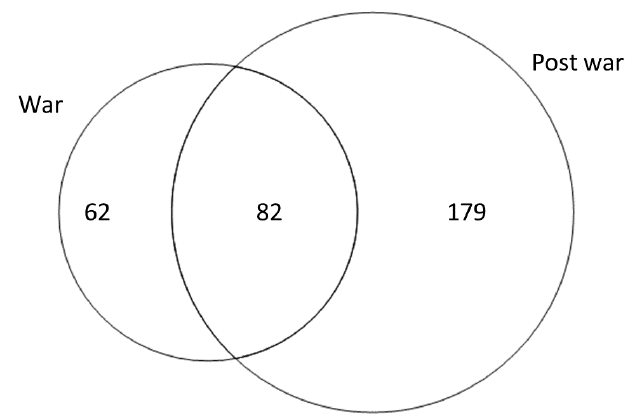
Figure 6. Venn diagram comparing the number of taxa promoted during the war and in post-war period, and the overlapping taxa. Table 2. The 29 most popular taxa in the two research periods.